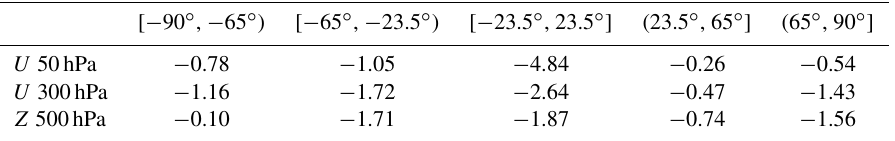
Table 1. Mean relative difference in 24–120h forecast RMSE between the EXP_A and the CTRL run (%) averaged over the polar, midlatitude and tropical region in the Northern Hemisphere and Southern Hemisphere for the 50hPa zonal-wind component ( U ), the 300hPa zonal-wind component ( U ) and 500hPa geopotential ( Z